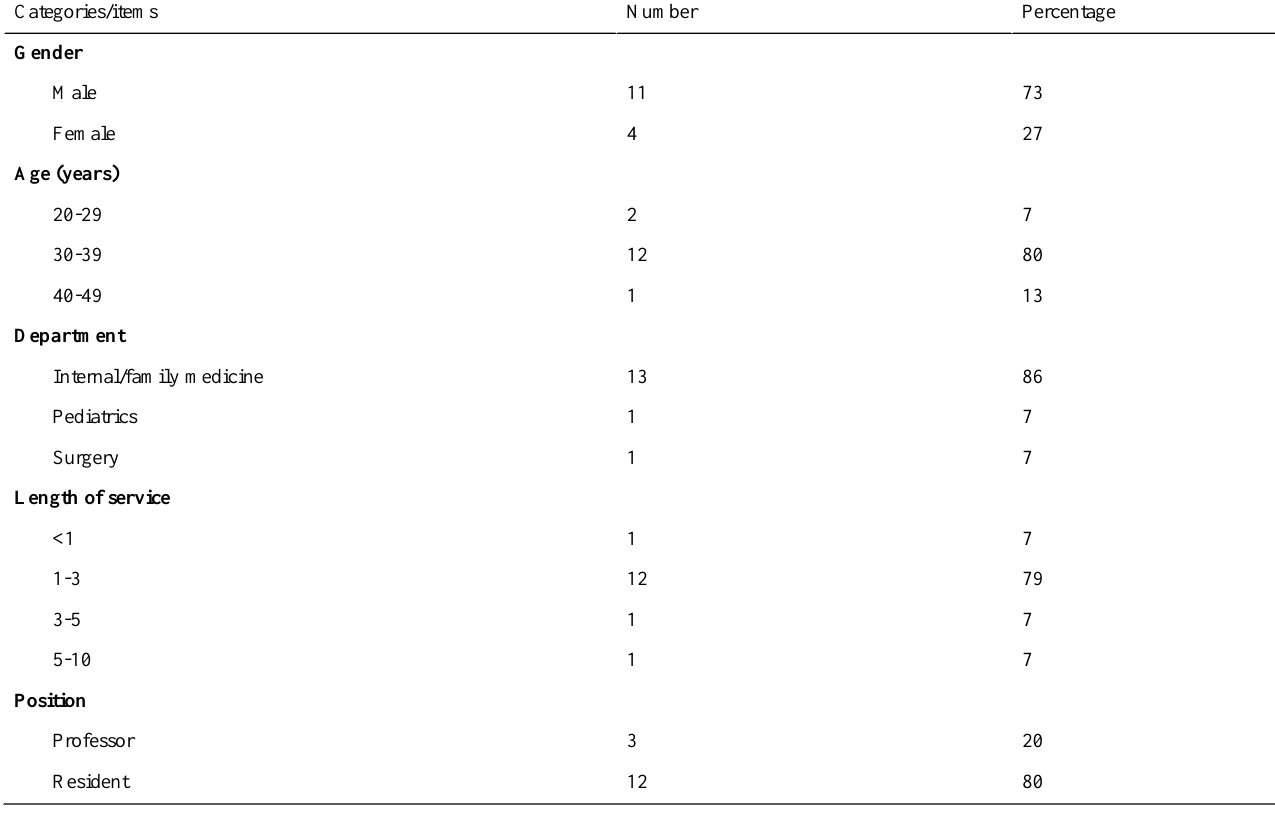
Table 3. Demographic characteristics of focused interview participants.